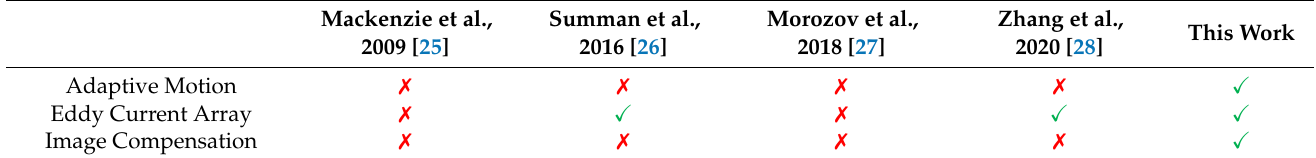
Table 1. Comparison between previously published robotically deployed eddy current inspections and this